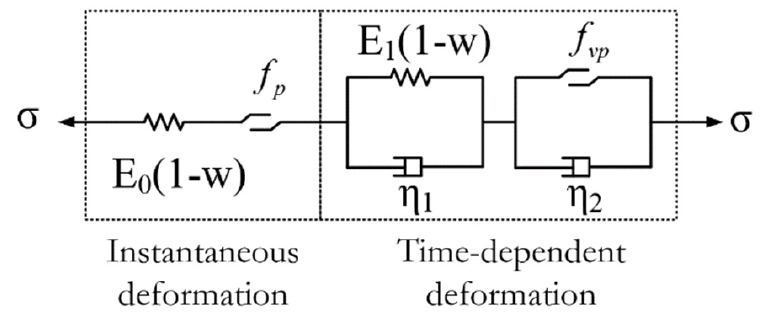
Figure 8. Schematic diagram of the improved Nishihara model.